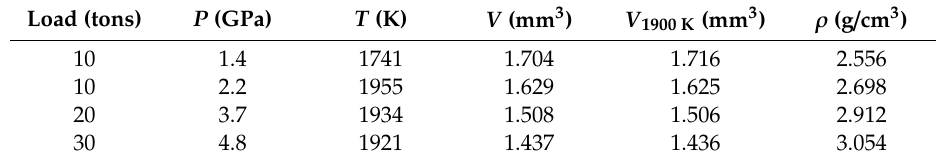
Table 1. Experimental pressure-temperature conditions and measured densities for jadeite melt. Load (tons) P